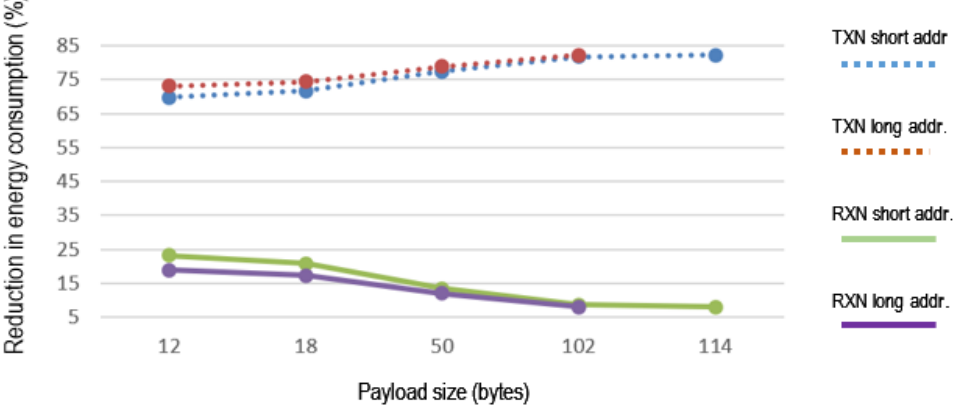
Figure 15. Reduction in energy consumption.